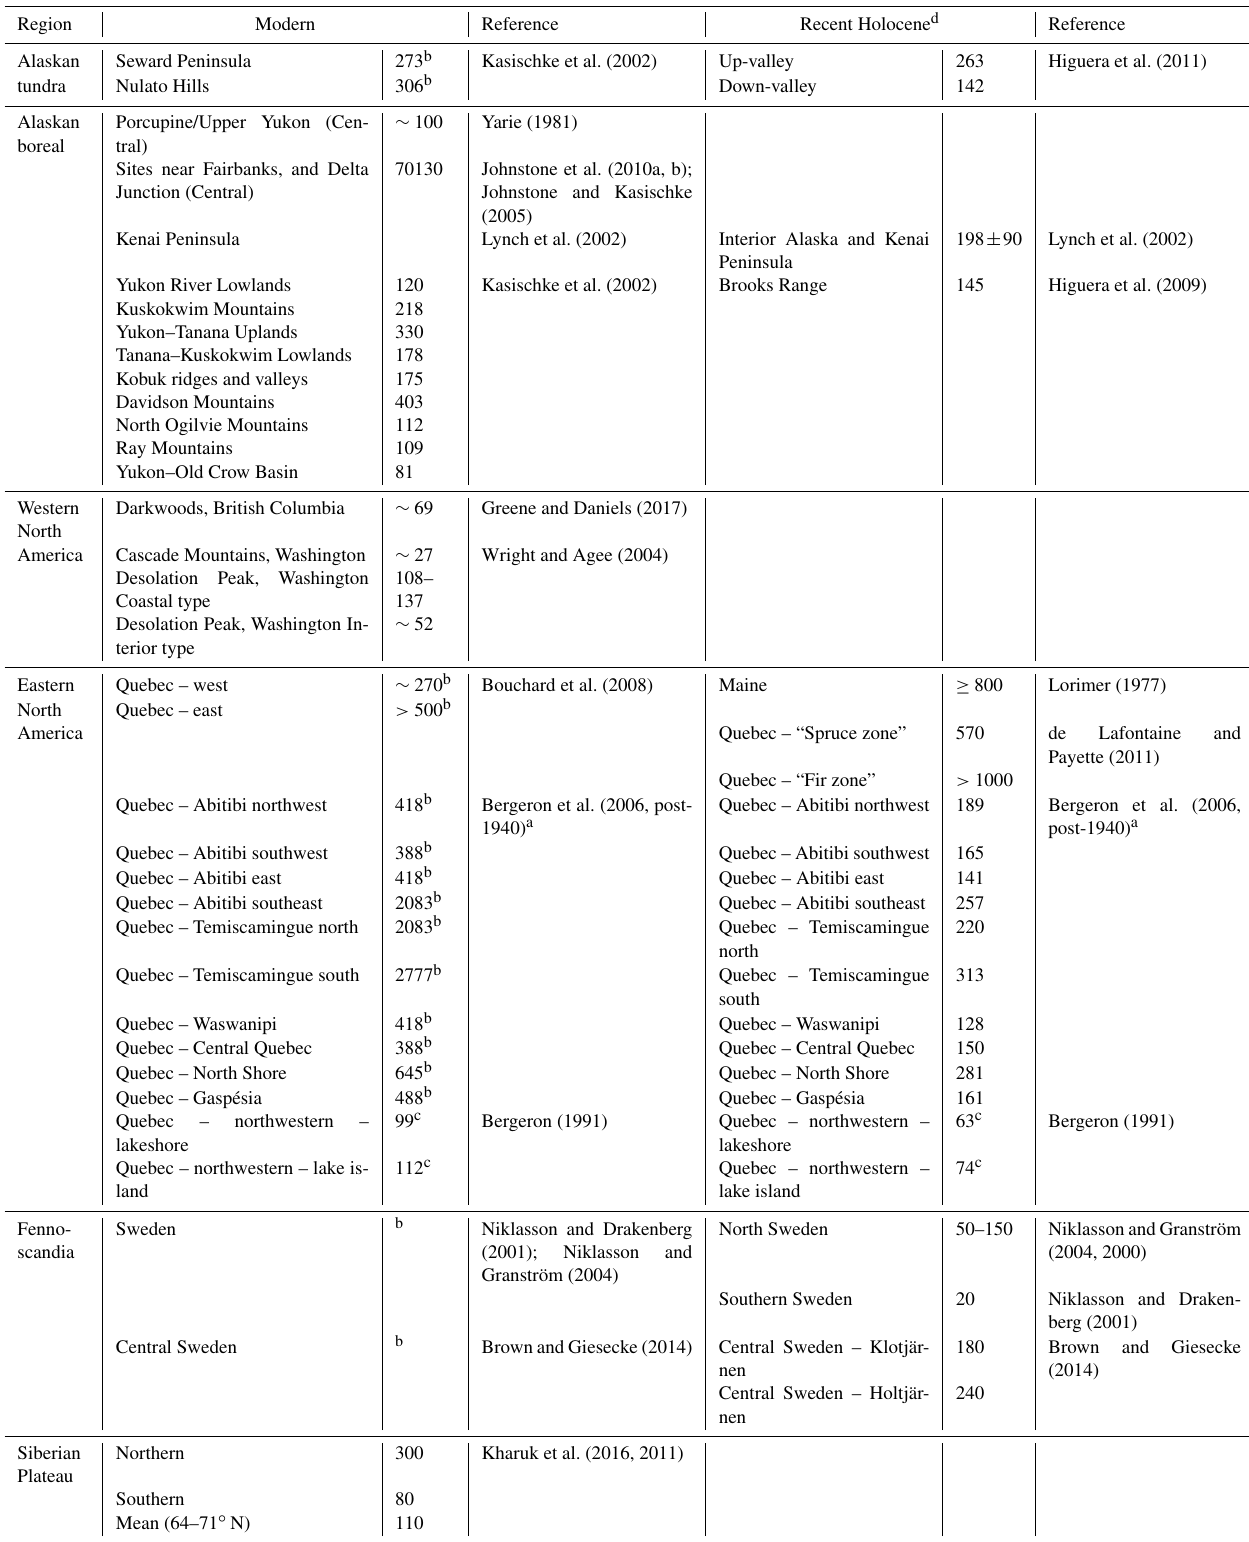
Table 1. Modern and recent Holocene fire return interval reconstructions for the candidate analogous regions considered in this study.